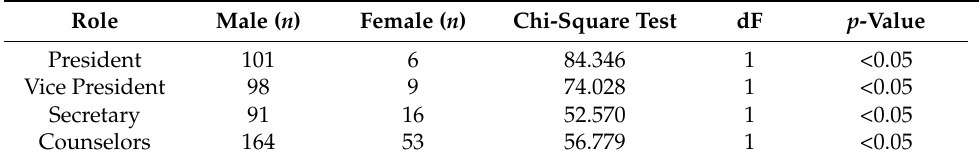
Table 2. Chi-square tests, dF (degree of freedom) values, and p -values to evaluate the different distributions of the genders in the different roles in national and local dental boards. dF = degree of freedom.